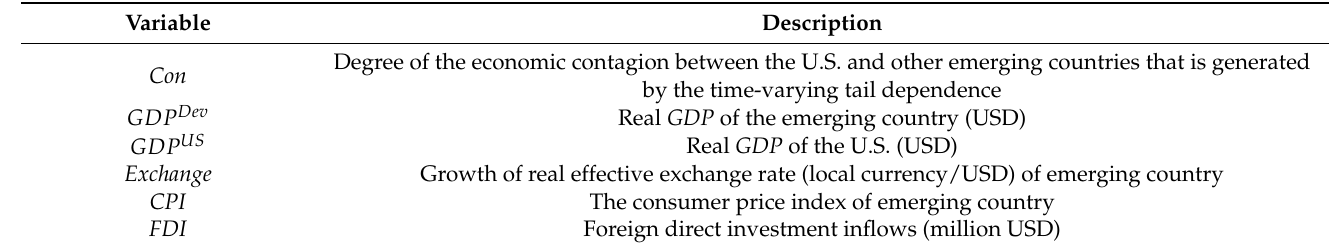
Table 1. Definition of